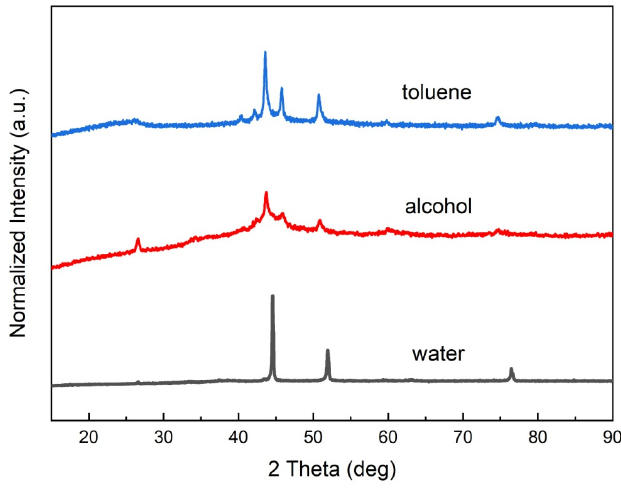
Figure 4. XRD patterns of encapsulated nickel particles obtained in three different liquids.